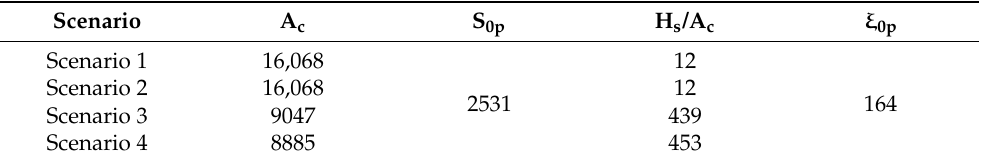
Table 6. Number of cases valid for the formula validity parameters